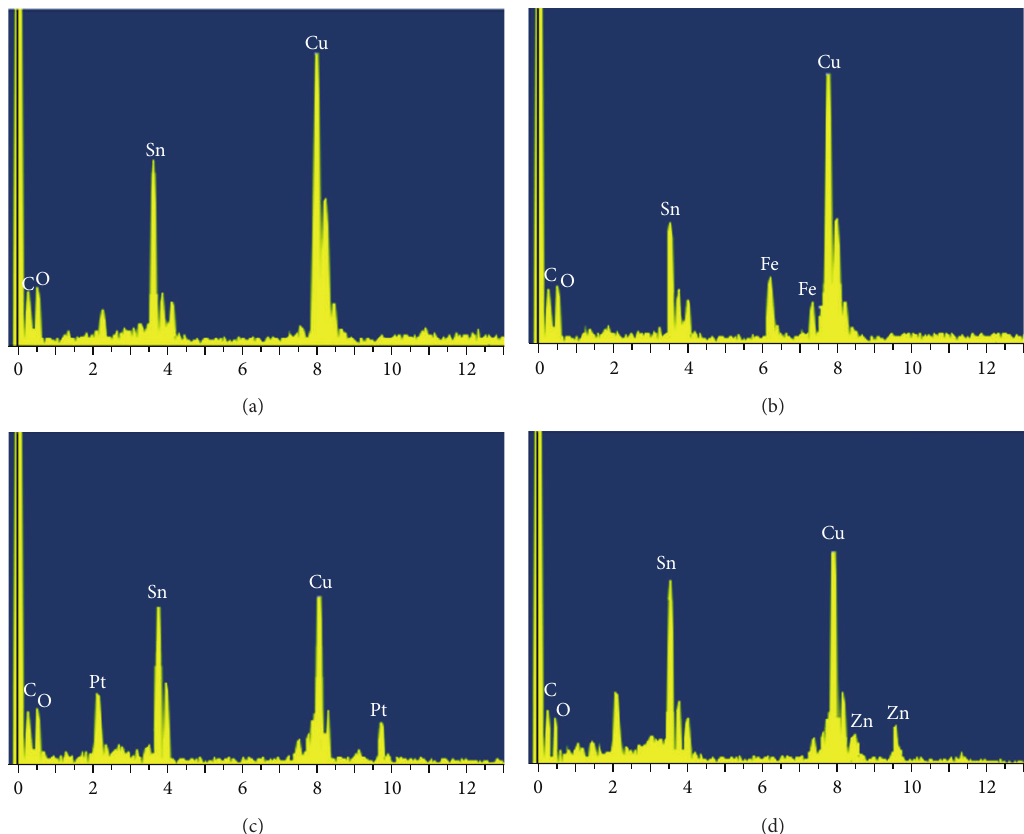
Figure 2: EDS spectra of pure, Fe-, Pt-, and Zn-doped SnO 2 nanospheres.